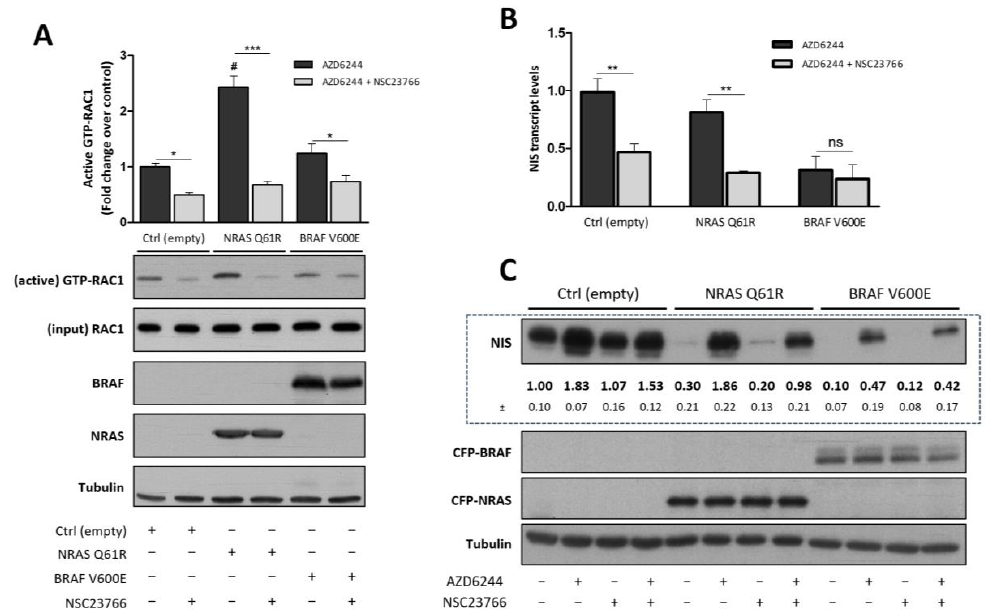
Figure 3. Effect of inhibiting MEK and RAC1 signaling on NIS expression. Transduced PCCL3 were serum-starved for 24 h, stimulated with TSH (1 mU/mL for 48 h; TSH plus) and treated with AZD6244 (10 µM for 48 h), either in the presence or absence of RAC1 inhibitor (NSC23766; 100 µM for 24 h). ( A ) Inhibition of endogenous RAC1 activity upon NSC23766